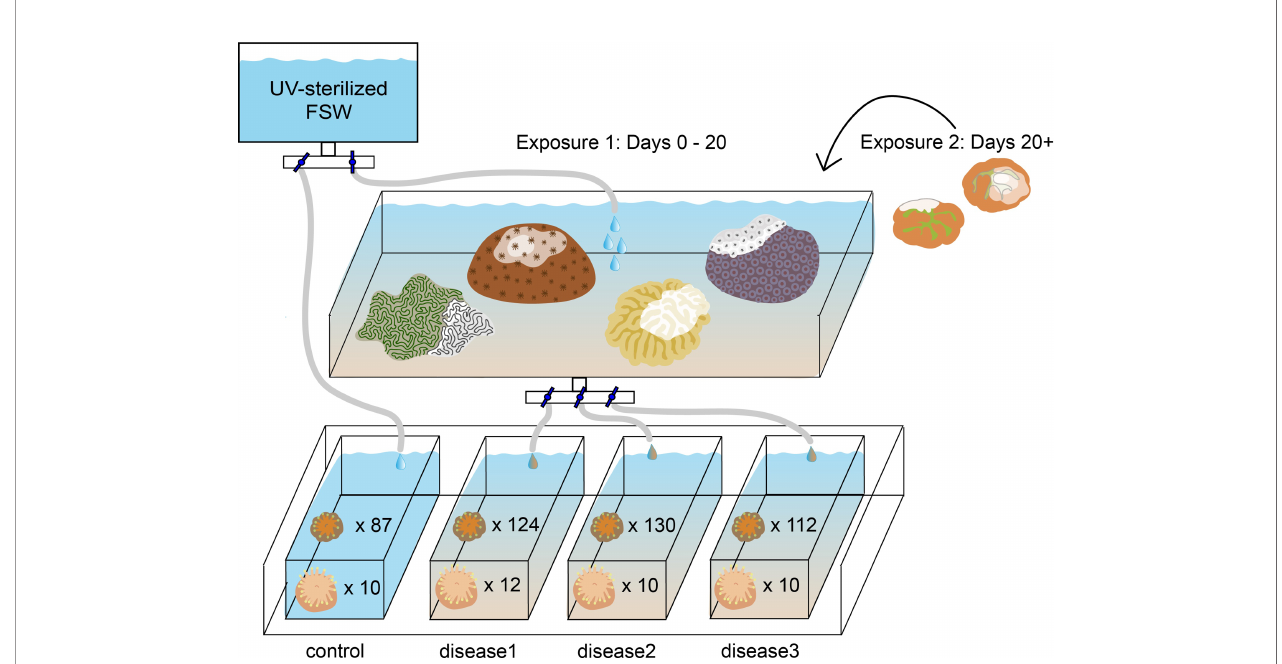
FIGURE 1 | Experimental setup exposing eight-month-old Diploria labyrinthiformis recruits (n=42) and four-month-old Colpophyllia natans recruits (n=453) to SCTLD. Each experimental tank contained ten C. natans plugs and six D.labyrinthiformis